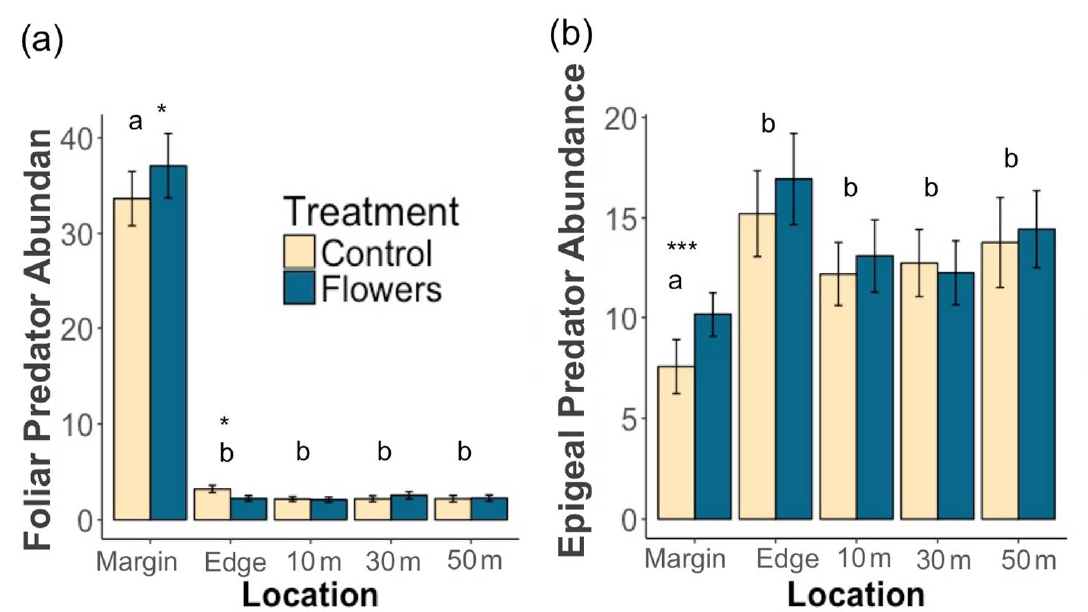
Figure 5. Mean (±1 SE) ( a ) epigeal predator abundance, and ( b ) foliar predator abundance. Asterisks denote significant differences between treatments at each location (* p < 0.05, *** p < 0.001). Letters denote significant differences in overall abundance between locations.